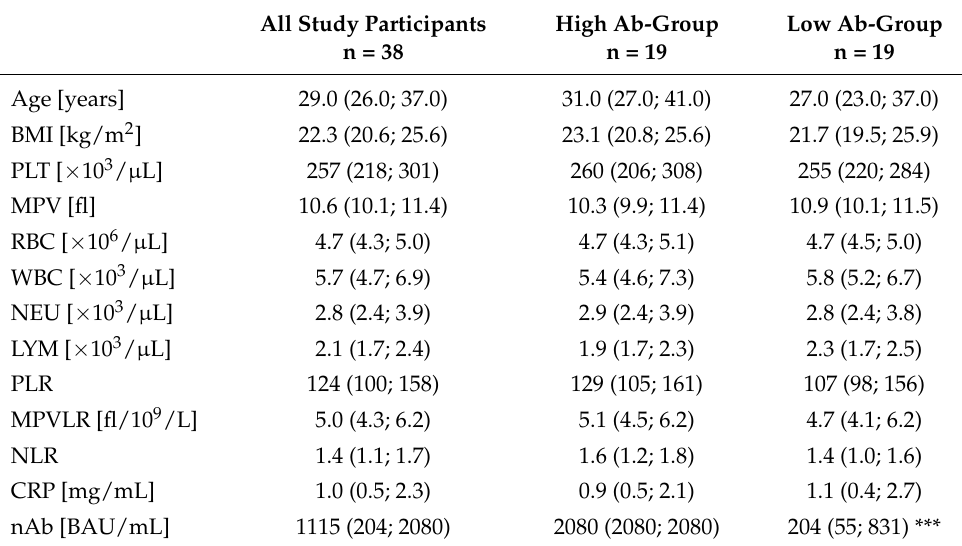
Table 1. Characteristics of the study participants enrolled for monitoring of platelet reactivity depending on anti-spike protein nAb concentration. All Study